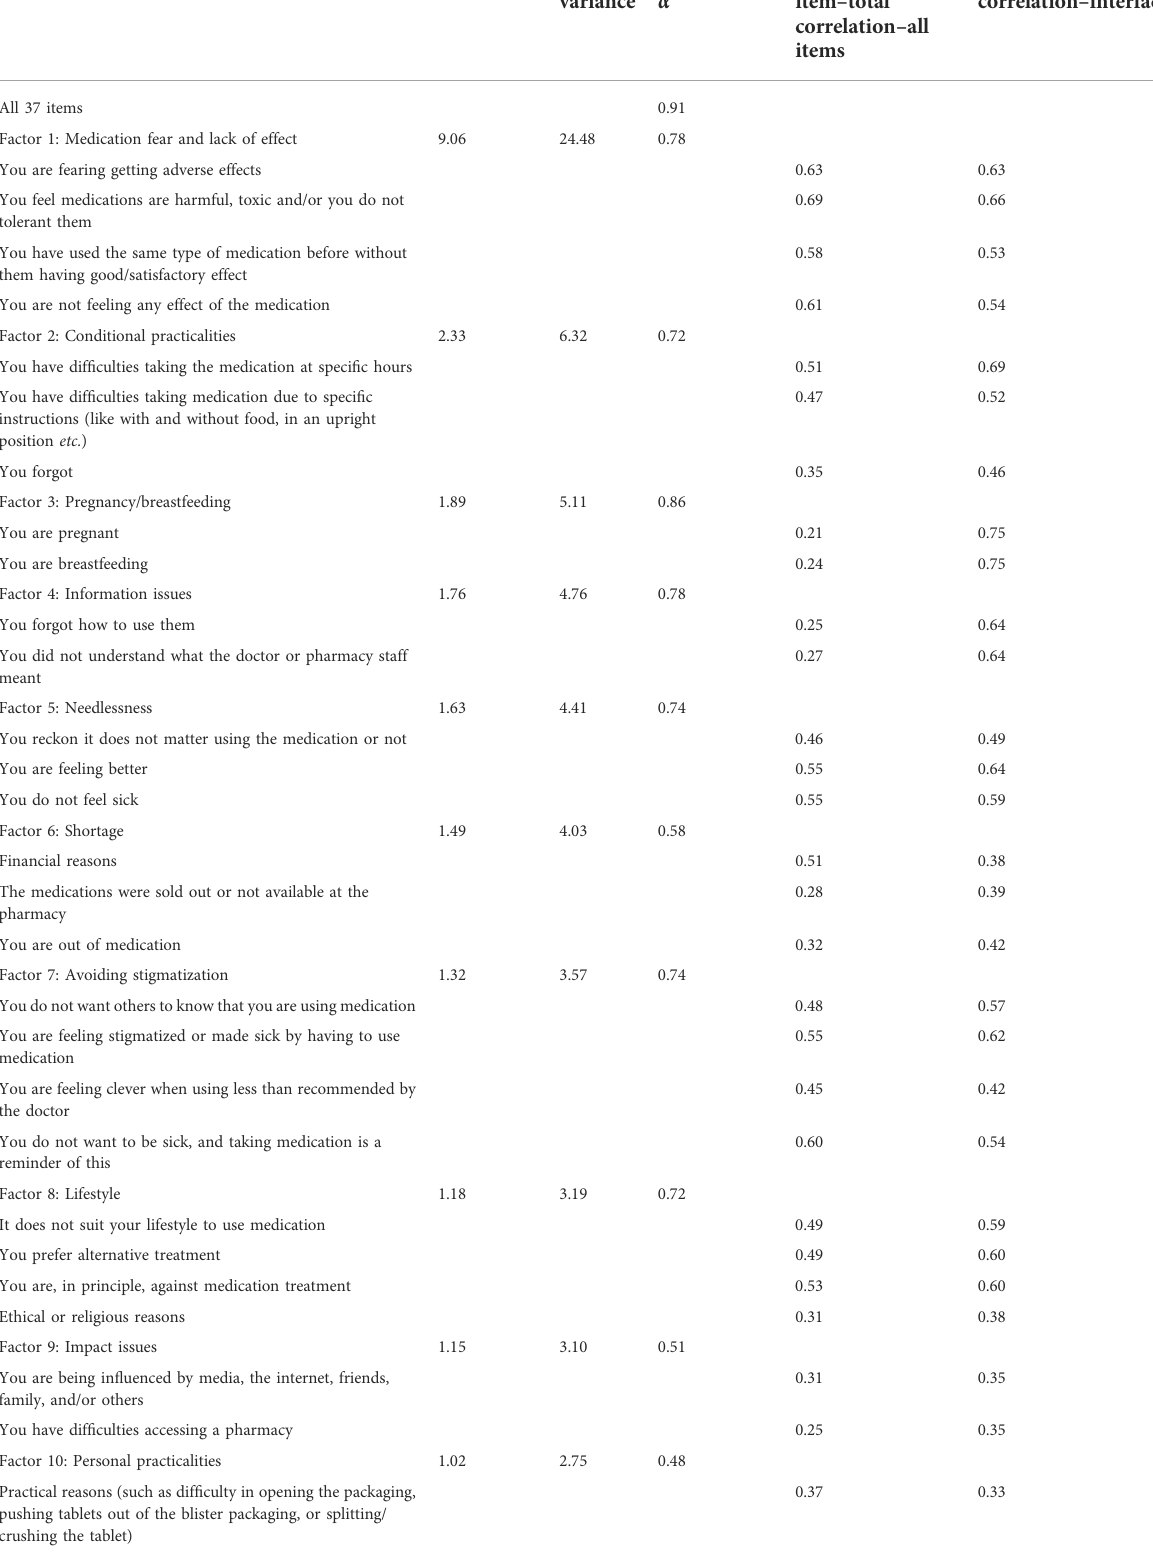
TABLE 4 Validation values for factors and items. Items Eigenvalue % of